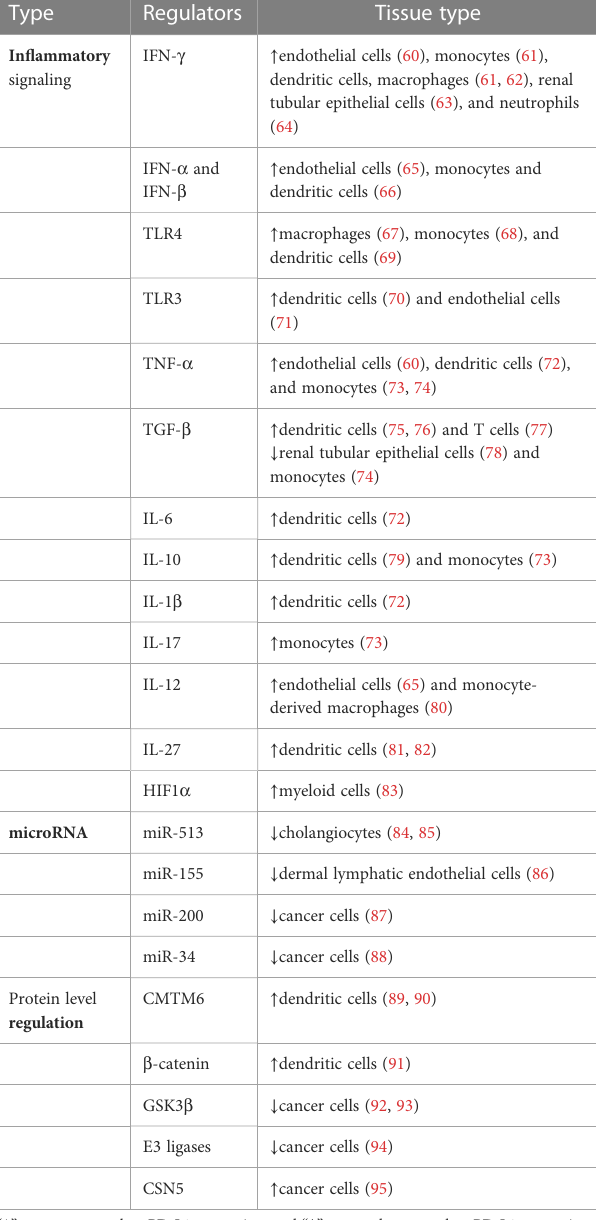
TABLE 1 Regulators of PD-L1 in normal cells.